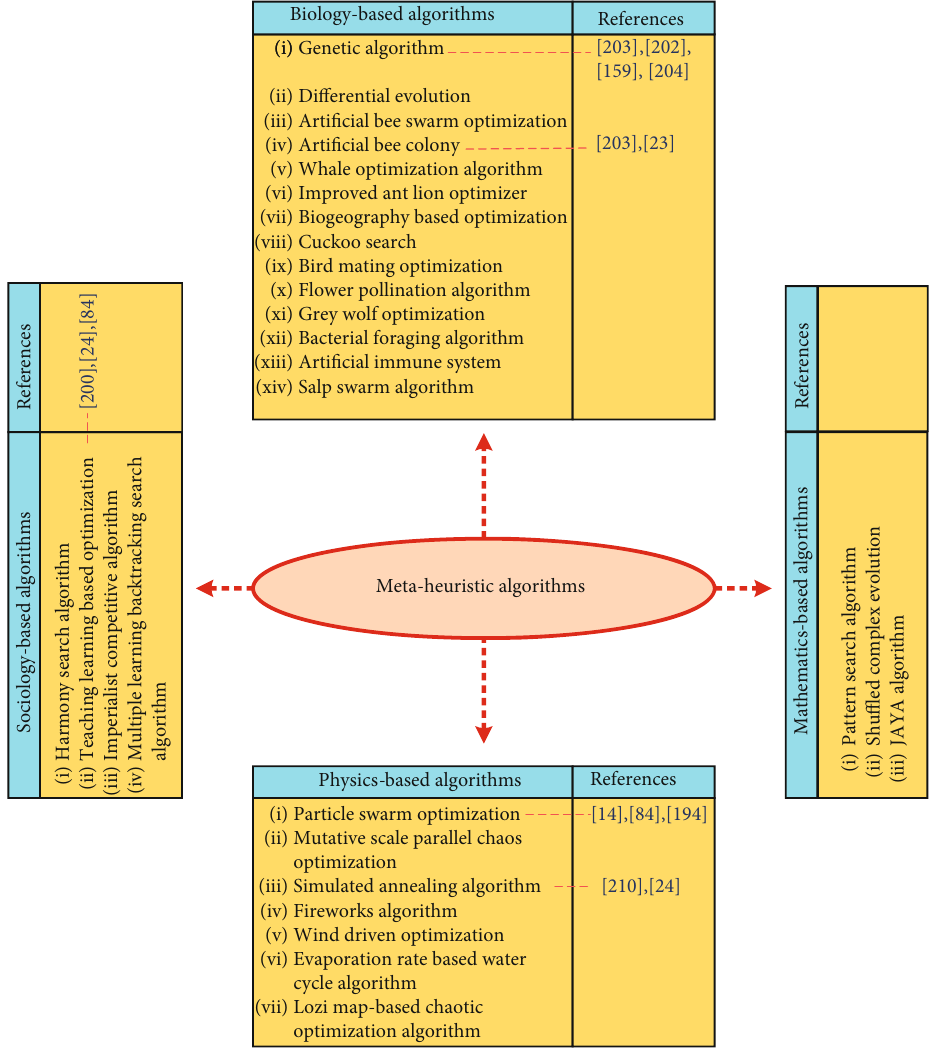
Figure 2: Classi fi cation of metaheuristic algorithms (biology-based algorithms, physics-based algorithms, sociology-based algorithms, and mathematics-based algorithms) and their applications in SAH optimization. Note: some algorithms do not have any references (that means they have never been applied to SAH optimization